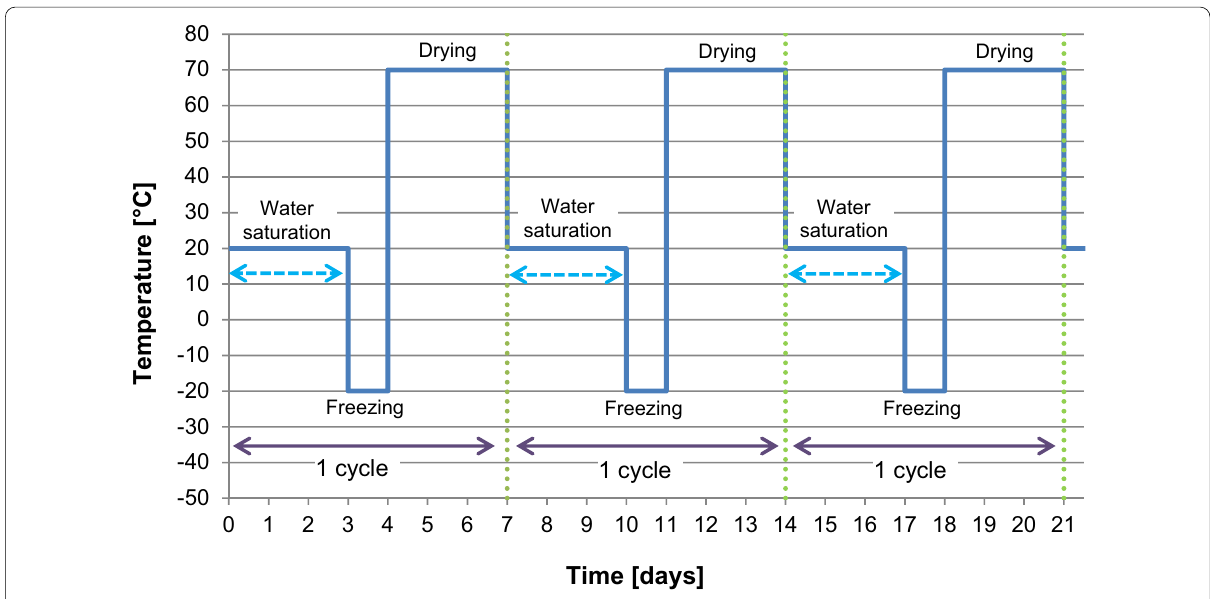
Fig. 8 Course of sudden changes of temperature and humidity (wet–frost–dry cycles)